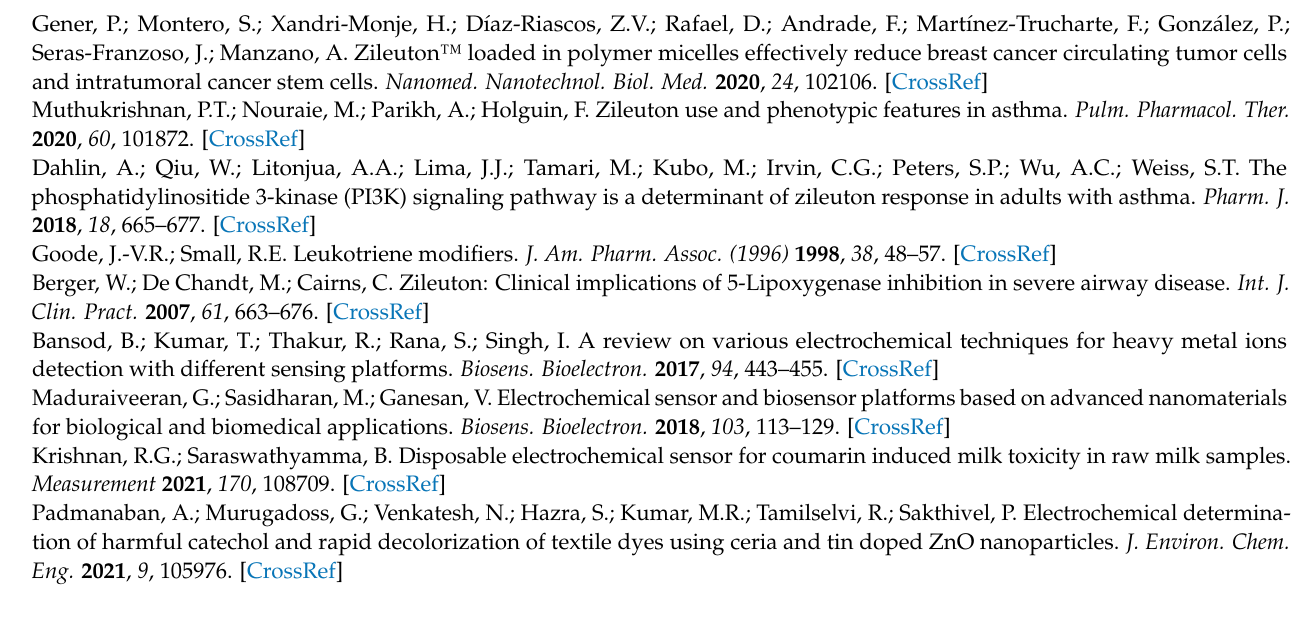
Figure S3: Impact of scan rate on the electrochemical behavior of 0.01mM ZLT at t imm of 0s in pH 6.0 (A) CV responses of 0.1 mM ZLT at different scan rates in pH 6.0 at G/CPE; Inset (a) Dependency and relationship of I pa and I pc with ν (B) Dependency and relationship of I pa and I pc with ν 1/2 ; (C) Plot of log I pa and log I pc versus log v ; (D) Plot of E pa and E pc versus log v , Figure S4: Study of influence and interference of (A) Excipients; (C) Metal ions; % signal change of ZLT under the influence of (B) Excipients; (D) Metal ions, Table S1: AFM characteristics of CPE and G/CPE, Table S2: Characteristics of the plot of peak current versus